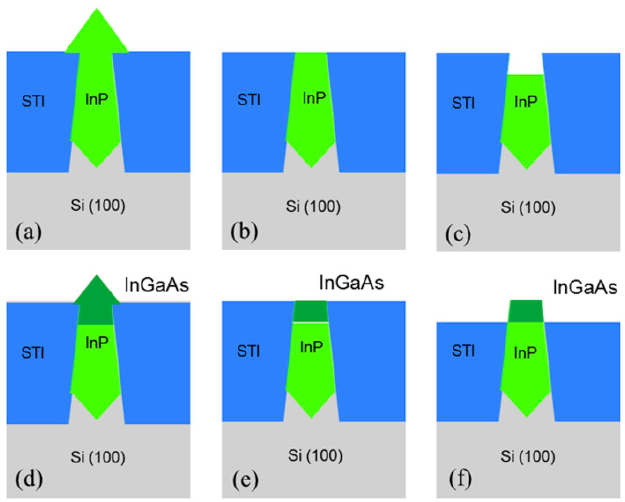
process steps are highlighted in red in the process flow description .